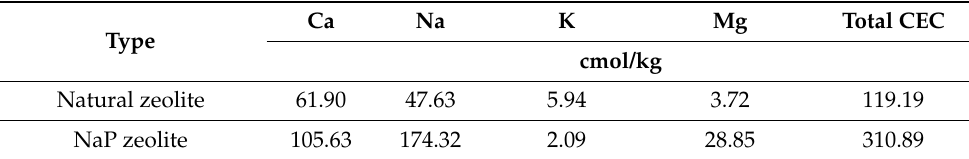
Table 3. Cation exchange capacity of natural zeolite and NaP zeolite.